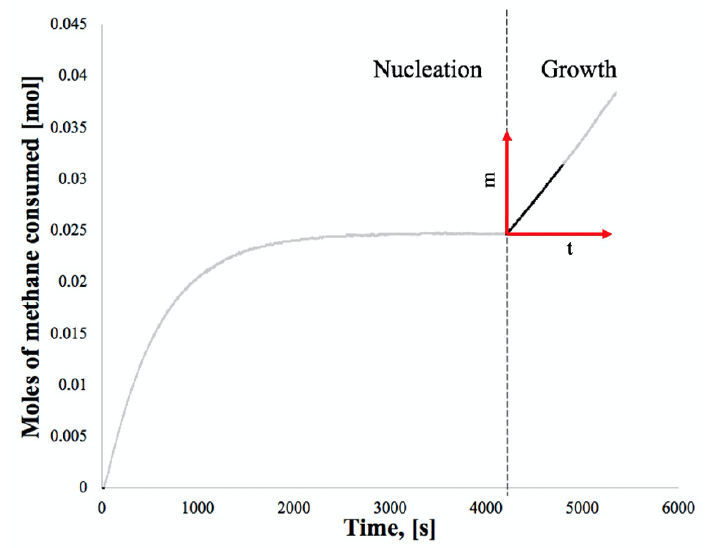
Figure 7. Expected curve obtained during hydrate growth experiments.